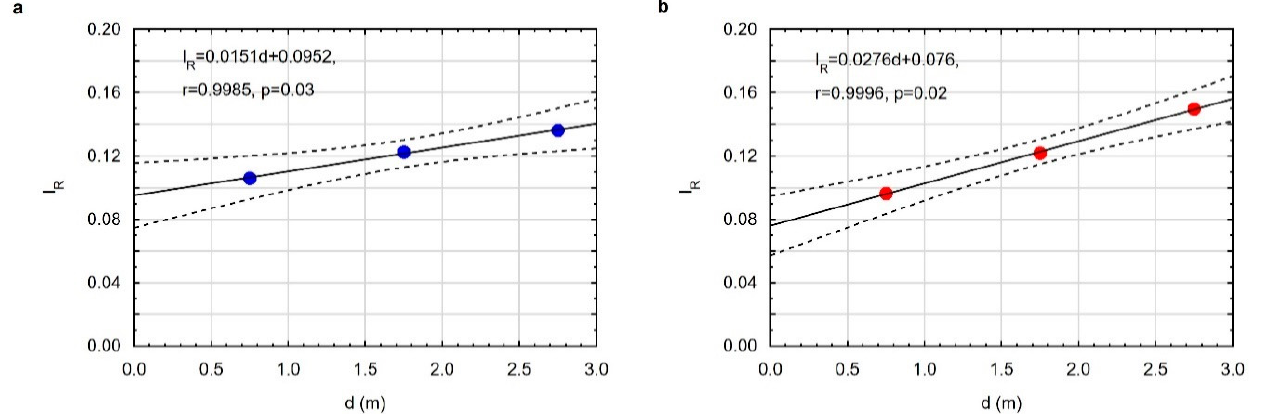
Figure 13. Relationship between I R ratio and distance from reactor chamber inlet at ( a ) pressure of 10 bar, and ( b ) pressure of 40 bar.